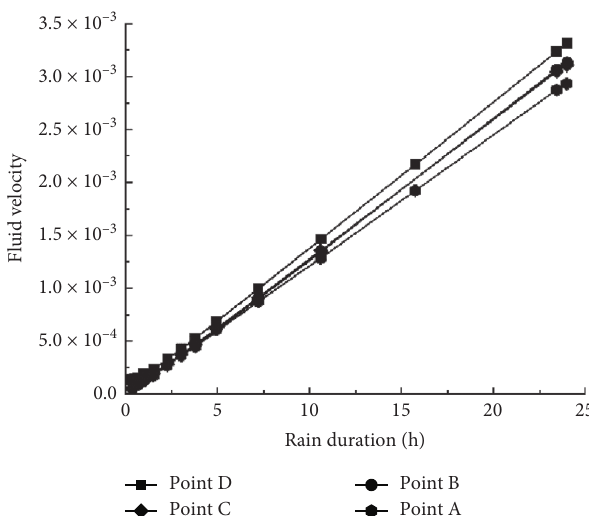
Figure 12: Curves of fluid velocity-rain duration at each point after rainfall for